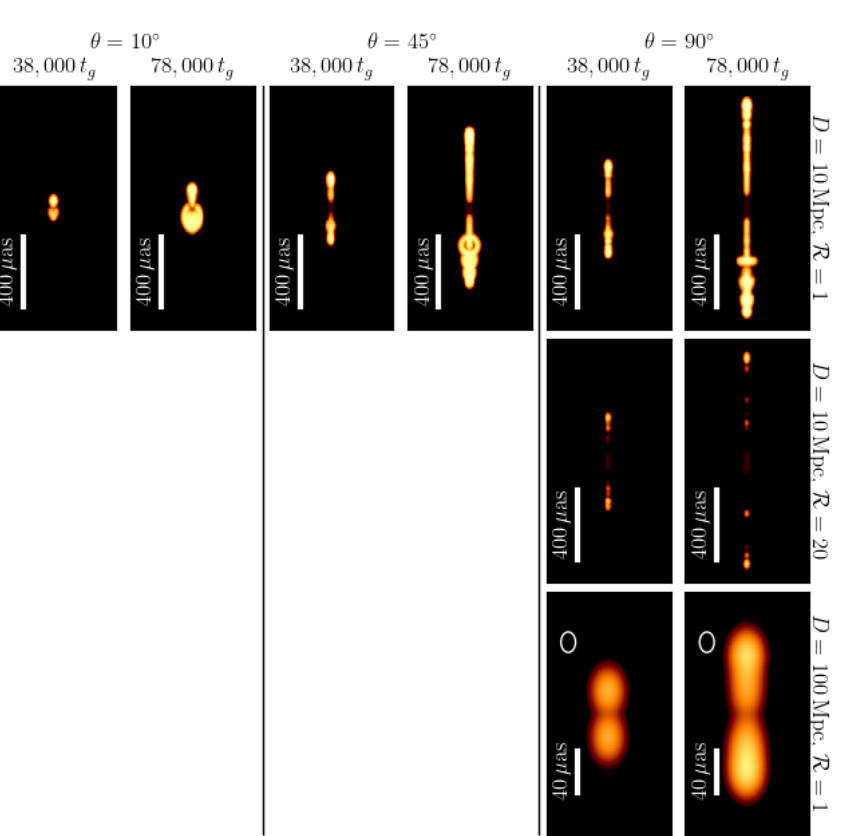
Figure A3. Here we show the full library of base ipole images for model m7a0.9-HR. Each image in the top and middle rows spans 1000 × 1400 µ as 2 , and the bottom row spans 170 × 238 µ as 2 . Each image was blurred by convolving the base image with a Gaussian beam with a FWHM of 20 µ as (indicated by the white circle in the bottom right panel). The time of each column is indicated at the top; the distance D and plasma temperature ratio R for each row are indicated on the right. The angle of the observer relative to the jet axis is indicated above each set of two rows. The color scale is logarithmic, spanning three orders of magnitude in each image. We used the same color scale for the D = 10 Mpc images, but reduced the maximum by an order of magnitude in the D = 100 Mpc images to better show the image